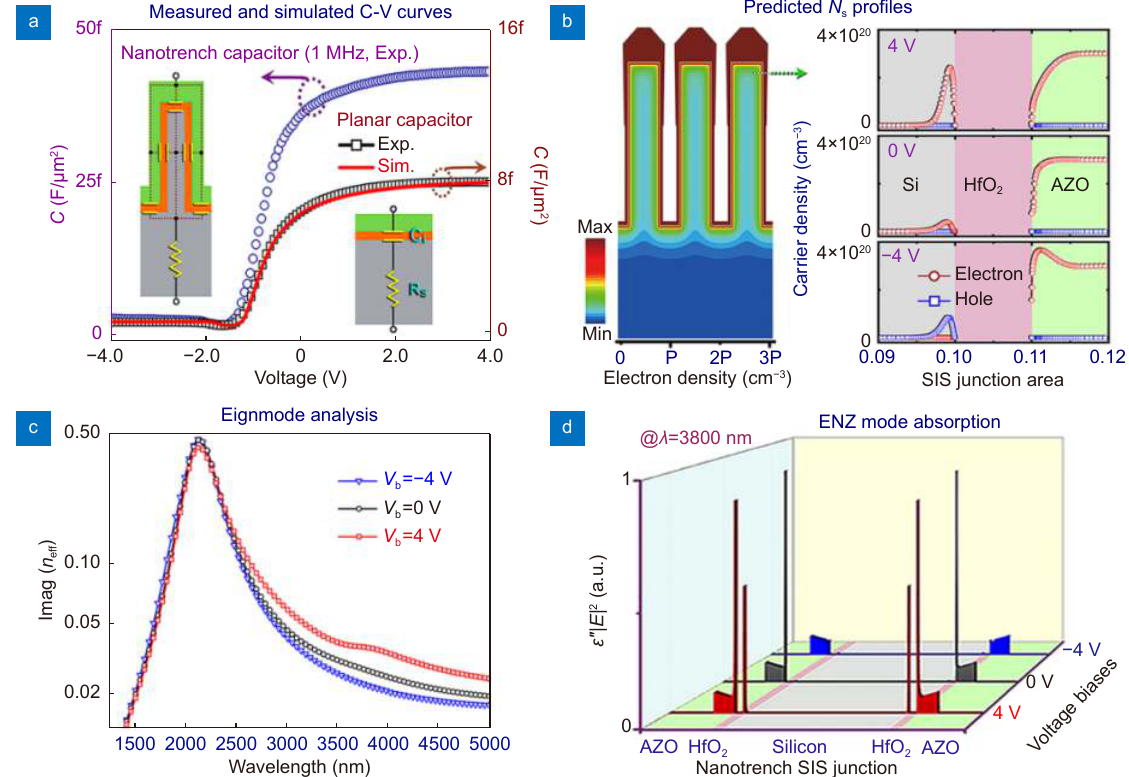
Fig. 4 | ( a ) The experimental measured high frequency C-V curves of the nanotrench and planar SIS capacitor (open symbols). The result of the planar reference was fitted very well with our electrical model (red line). ( b ) Voltage bias-dependent carrier profiles near the SIS junction area ob- tained from the TCAD modeling using the derived electrical parameters. ( c ) The imaginary part of the effective index of the fundamental mode supported by the SIS nanotrench. In the PDE calculations, the spatially varied optical constants of the SIS junction were extrapolated by the Drude model using the carrier profiles shown in (b). ( d ) The P abs distribution across the SIS junction at a wavelength of 3800 nm representing the ENZ modes modulated by voltage